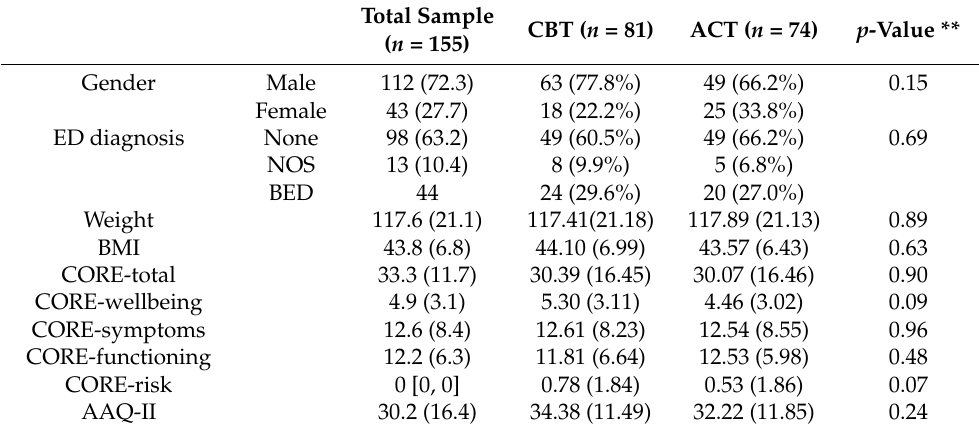
Table 2. Descriptive statistics of the total sample and of the ACT and CBT groups at